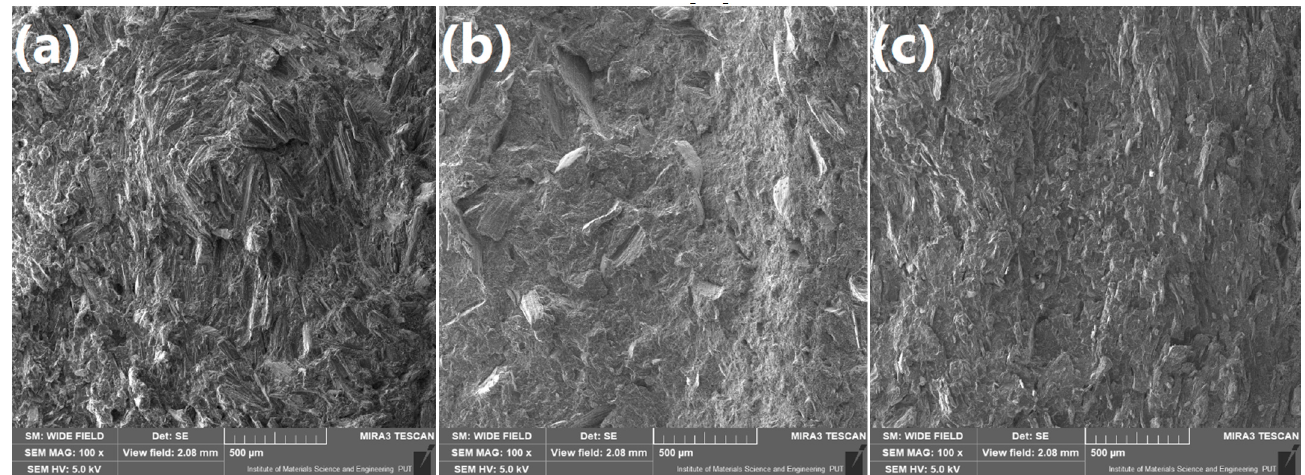
Figure 6. SEM images of brittle fracture areas of samples ( a ) WF 100 , ( b ) WF 0 BSG 100 , and ( c ) WF 0 ŁK 100 under magnification of x100.